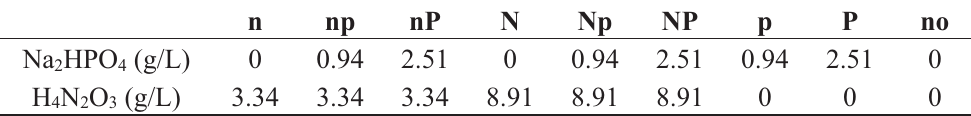
Table A1. Fertilization treatments for Lythrum salicaria in a pot experiment in the common garden. Per treatment we used 25 plants. Plants were watered once a week with 1 L nutrient